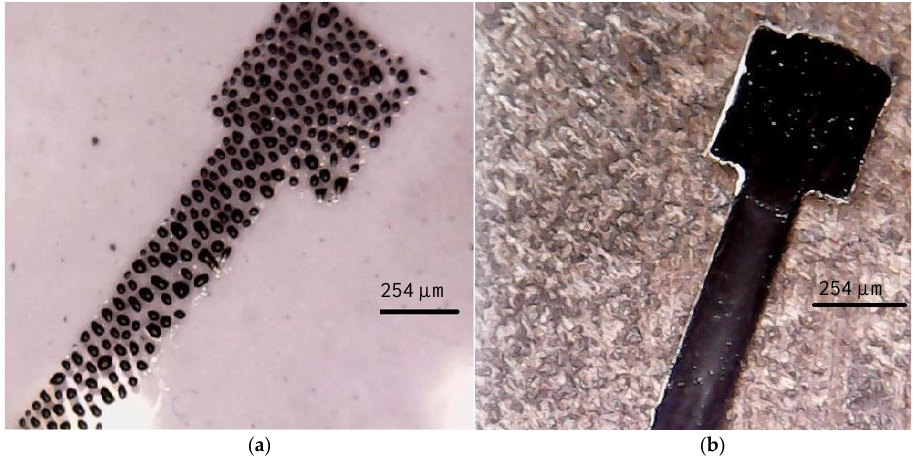
Figure 2. Printed silver NP ink on: ( a ) untreated PDMS surface; and ( b ) treated PDMS surface.